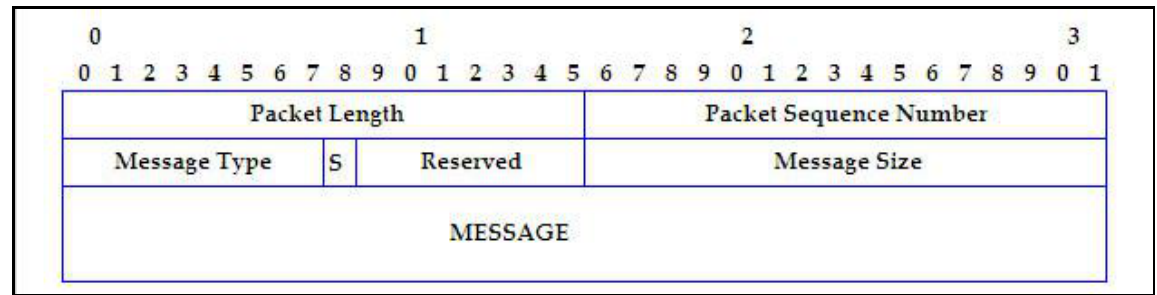
Figure 2. Packet from the D2HCP protocol.